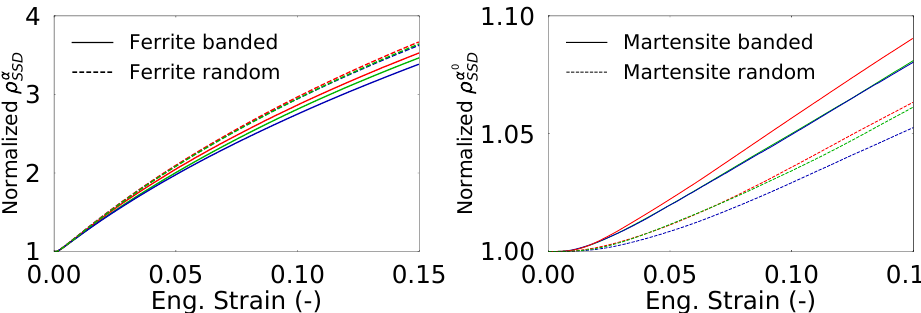
Figure 9. Evolution of normalized SSD density (with respect to ρ 0 martensite ( right ). Each color represents an orientation set.